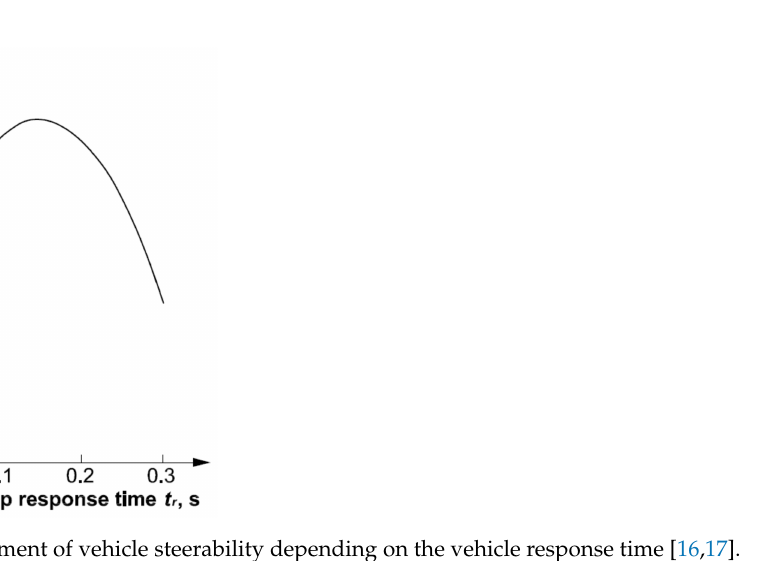
Figure 1. Assessment of vehicle steerability depending on the vehicle response time